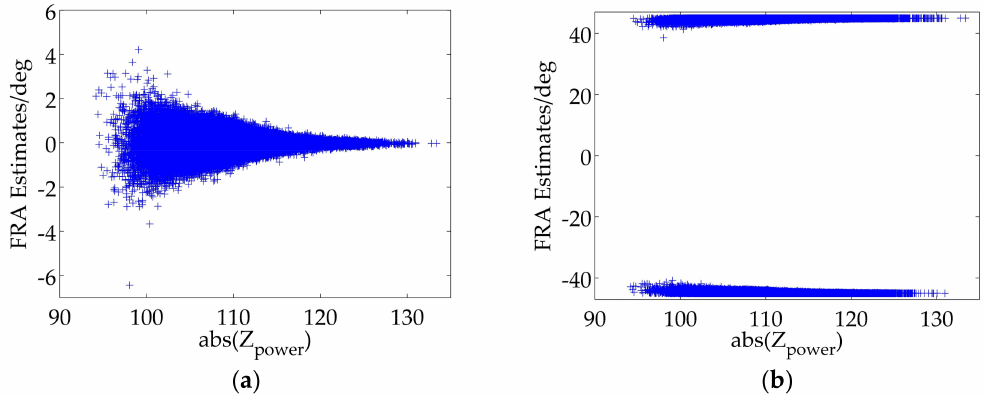
Figure 6. ( a ) FRA estimates for the original real data; ( b ) FRA estimates as the true FRA is set to 45 ◦